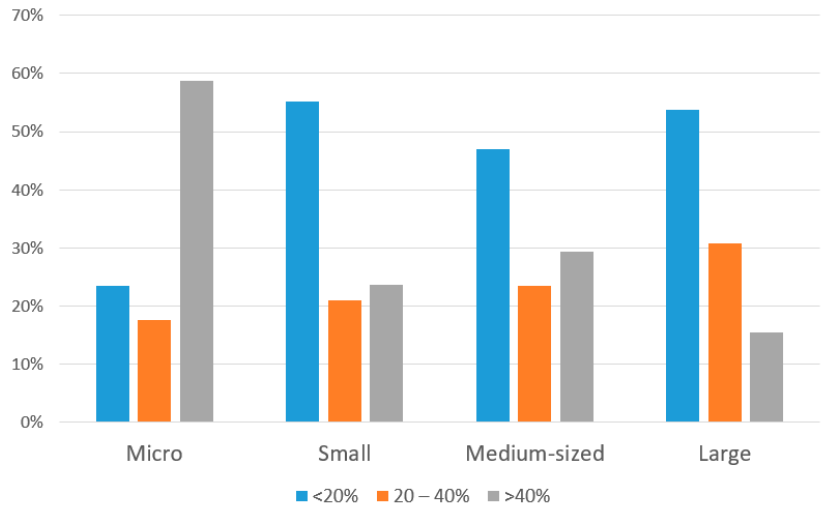
Figure 1. Success rate in public procurement according to the size of the company. As contractors may be influenced by EVoP when determining their bid price, respon- dents were asked to evaluate how much they take EVoP into account (on a six-point Likert scale). The data was evaluated by using RII as shown in Table 1. Respondents were grouped